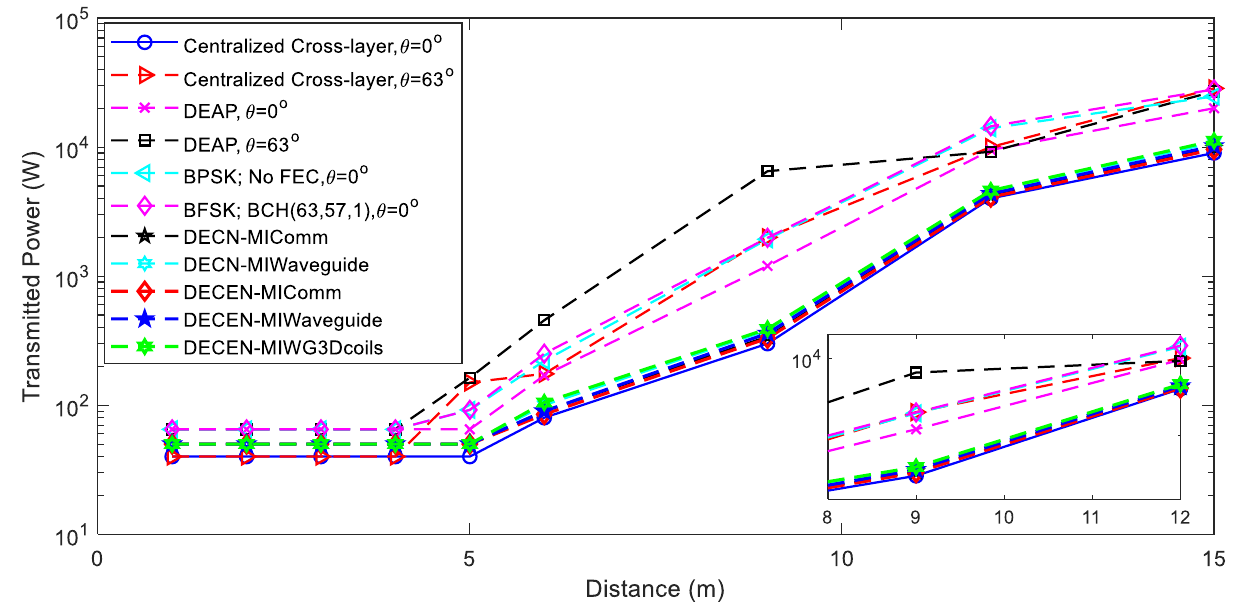
Figure 7. Comparison graph for transmitted power as a function of distance.